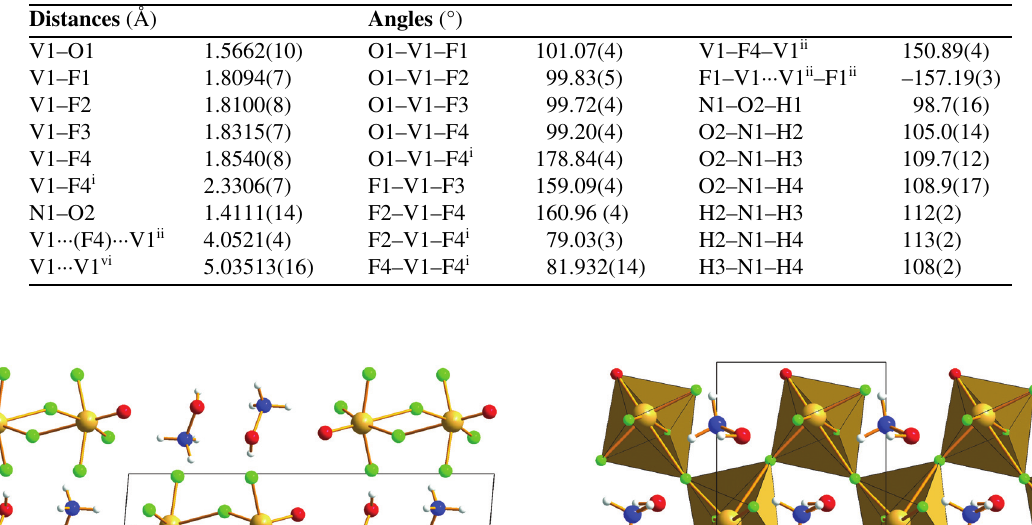
] 2– dianion, 25,15 as well as the packing similarities O F 2 2 8